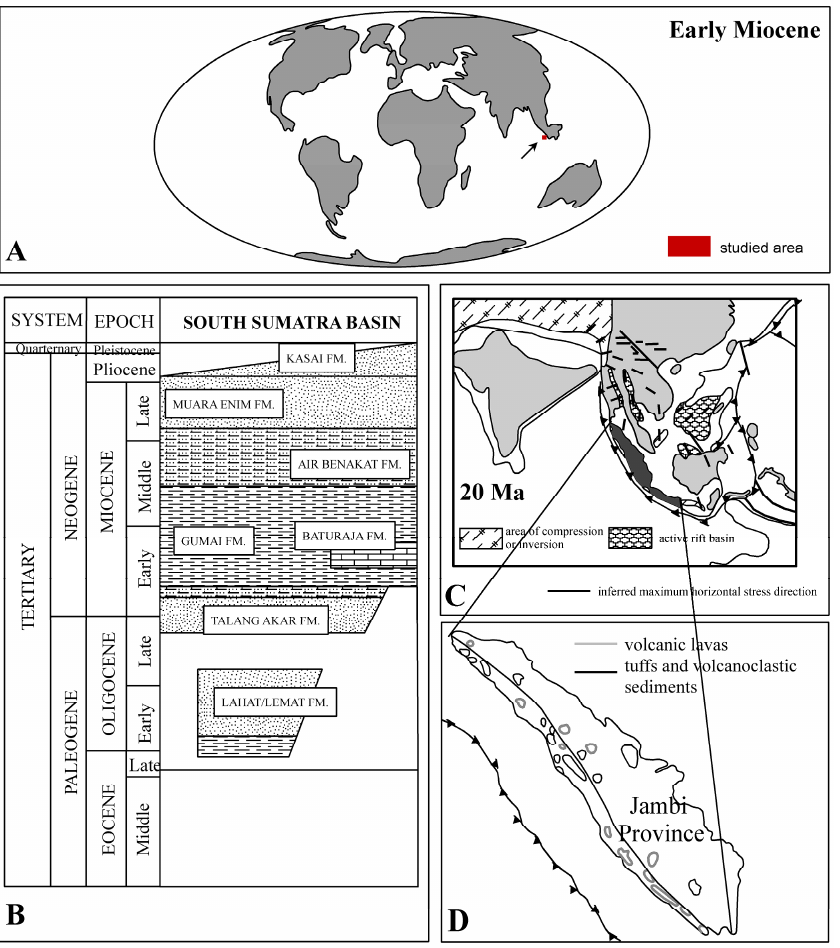
Figure 2. ( A ) tectonic map of Miocene world; ( B ) geological profile of South Sumatra Basin (on the basis of [23]); ( C ) Indonesia during Miocene epoch (modified after [22]); ( D ) volcanic units of the island of Sumatra (according to [23]).